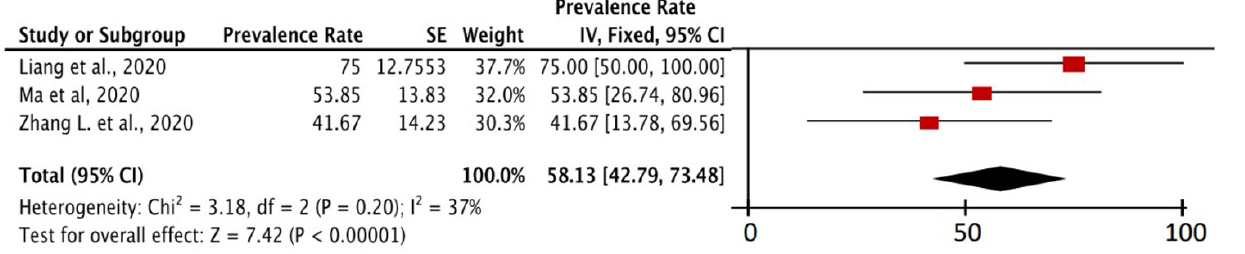
Figure 5. Forest plot of prevalence of severe event in COVID-19 patients with cancer as a comorbid and a history of anticancer